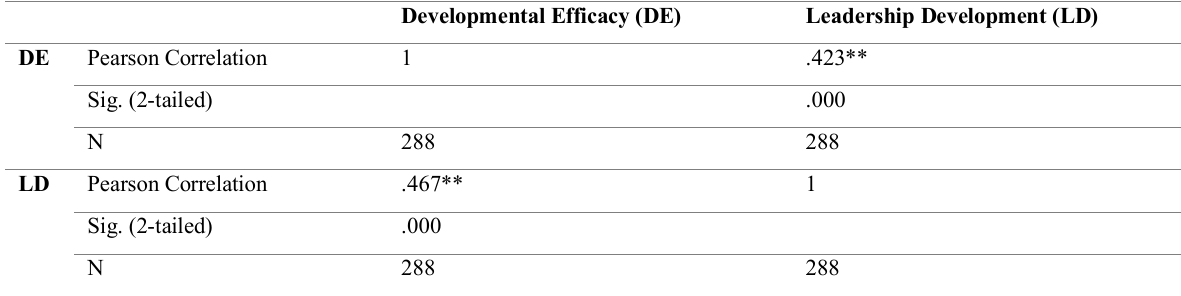
Table 1: Correlation between developmental efficacy and leadership development